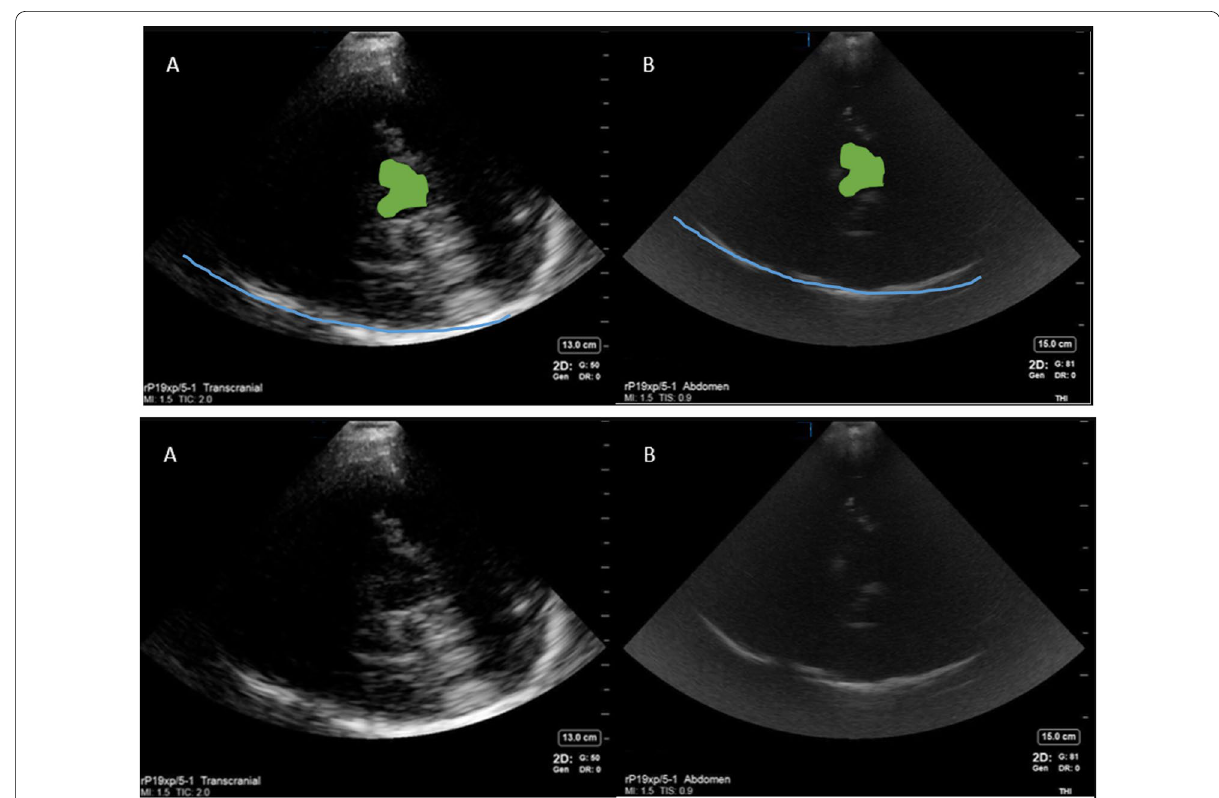
Fig. 4 Artifact created by acoustic shadow of the midbrain causing a false positive finding of hemorrhage More visible on transcranial preset A but less enhanced on abdominal preset B . Blue line—opposite skull, green—midbrain